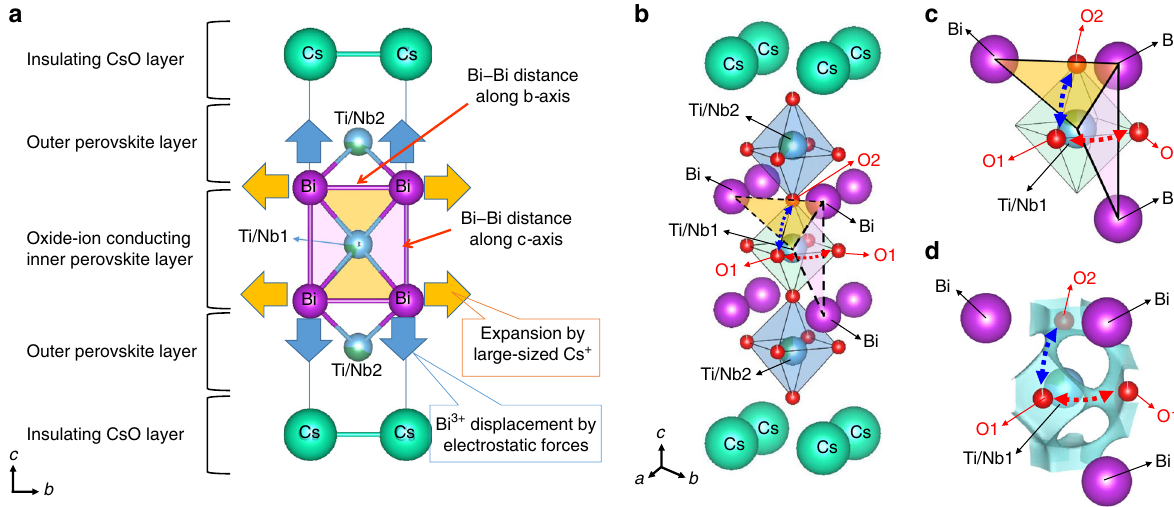
Fig. 5 New concept of enlarged bottlenecks for oxide-ion migration by large size of Cs + and Bi 3 + displacement. a New concept of enlarged bottlenecks for oxide-ion migration created by large size of Cs + and Bi 3 + displacement in Dion – Jacobson-type Cs/Bi-cation-ordered CsBi 2 Ti 2 NbO 10 − δ ( − 1/2 ≤ x , y , z ≤ 1/2). Yellow and pink Bi – Bi – Ti triangles stand for the areas of bottlenecks for O1 – O2 and O1 – O1 oxide-ion migration, respectively. Oxygen atoms are omitted for simplicity in a . b Re fi ned structure and Bi – Bi – Ti/Nb1 triangle bottleneck of CsBi 2 Ti 2 NbO 9.80(2) at 973 K ( − 1/2 ≤ x , y , z ≤ 1/2). A part of the structure ( c ) and corresponding bond-valence-based energy landscape (BVEL) with the isosurface at 0.6 eV ( d ), showing the O1 – O2 and O1 – O1 oxide-ion diffusion paths. Blue and red-dotted lines with arrows denote the possible O1 – O2 and O1 – O1 diffusion pathways of oxide ion,